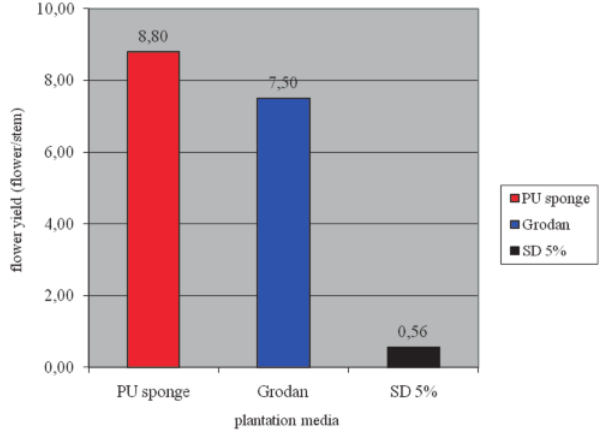
Figure 1. The effect of plantation media on the yearly yield of carnation ‘Pink Castellaro’ (Kecskemét, 1999–2000.)